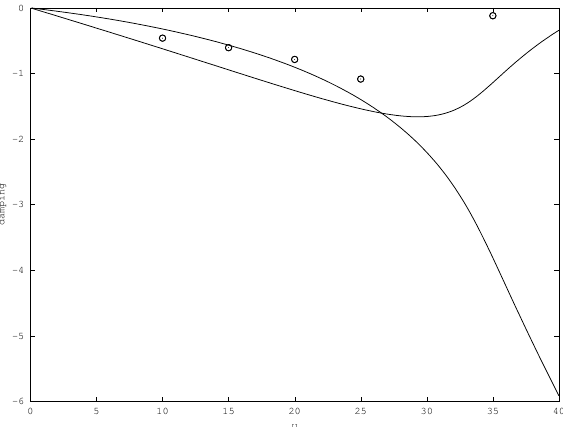
Fig. 4. The aerodynamical damping in dependence on the far field velocity U ∞ for the first considered aeroelastic prob- lem. The results obtained by the linearized aerodynamical the- ory (solid line) and by the finite element method (symbols) are